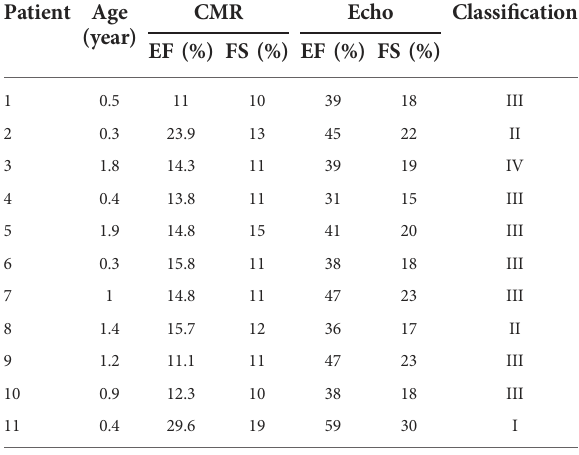
TABLE 3 Clinical cardiac function classi fi cation and EF and FS measured by CMR or Echo. Patient Age